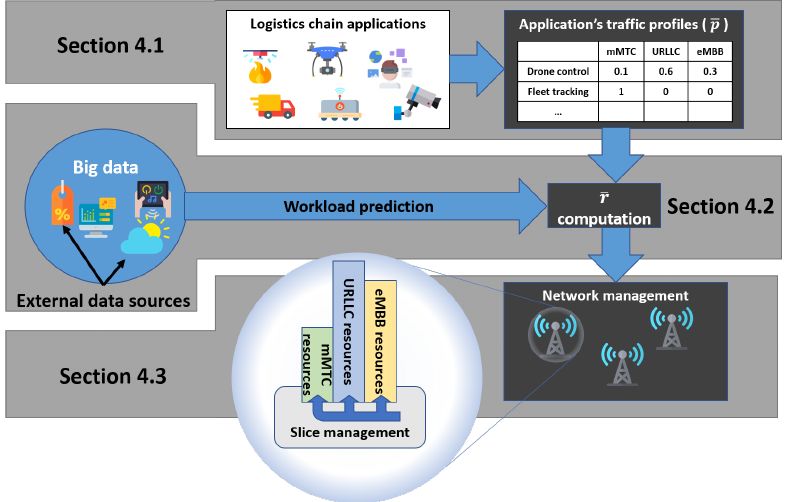
Figure 5. Overview of the proposed